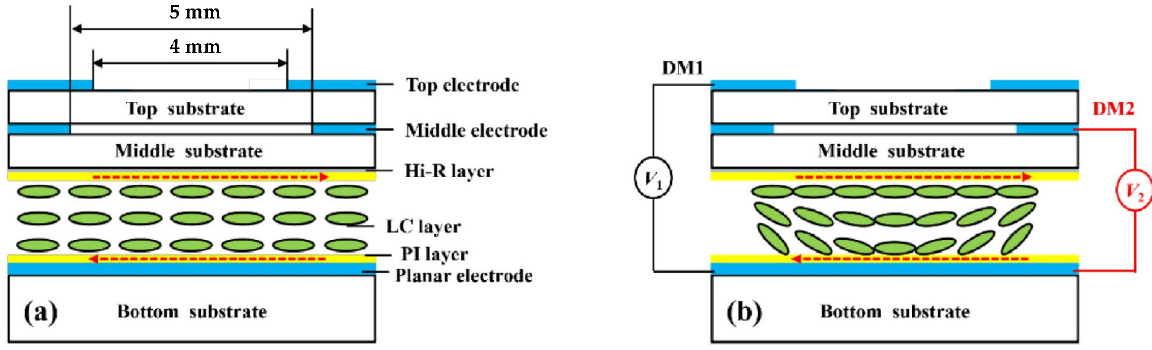
Figure 5. Dual-aperture LC lens at different working states: ( a ) when the voltage is on and ( b ) the voltage is off [49]. Reprinted with permission from Ref. [49]. 2022 Elsevier. voltage is off [49]. Reprinted with permission from Ref. [49]. 2022